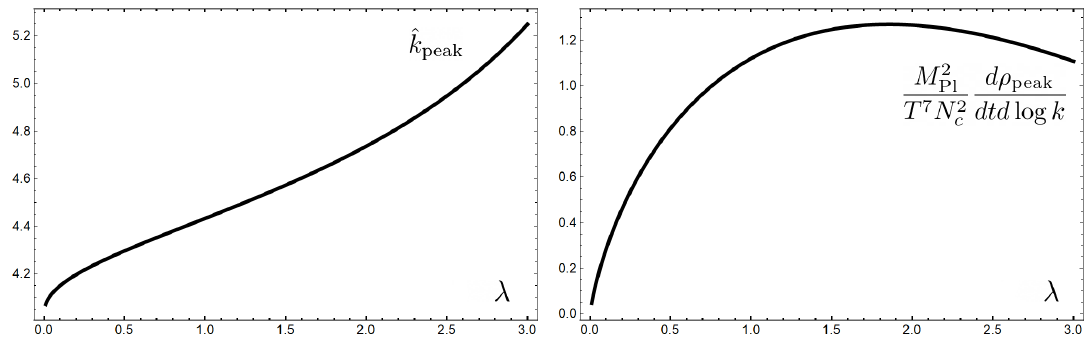
Figure 3 . Left: position of the peak wave number with respect to the coupling constant λ ; the perturbative analysis predicts that an increase in the interaction strength of the thermal plasma shifts the peak energy towards higher frequencies. Right: peak energy density with respect to the coupling constant λ ; contrary to ˆ k peak , the peak energy does not increase monotonically with λ , but rather increases until reaching a maximum value at λ max ∼ 1 . 8 , then